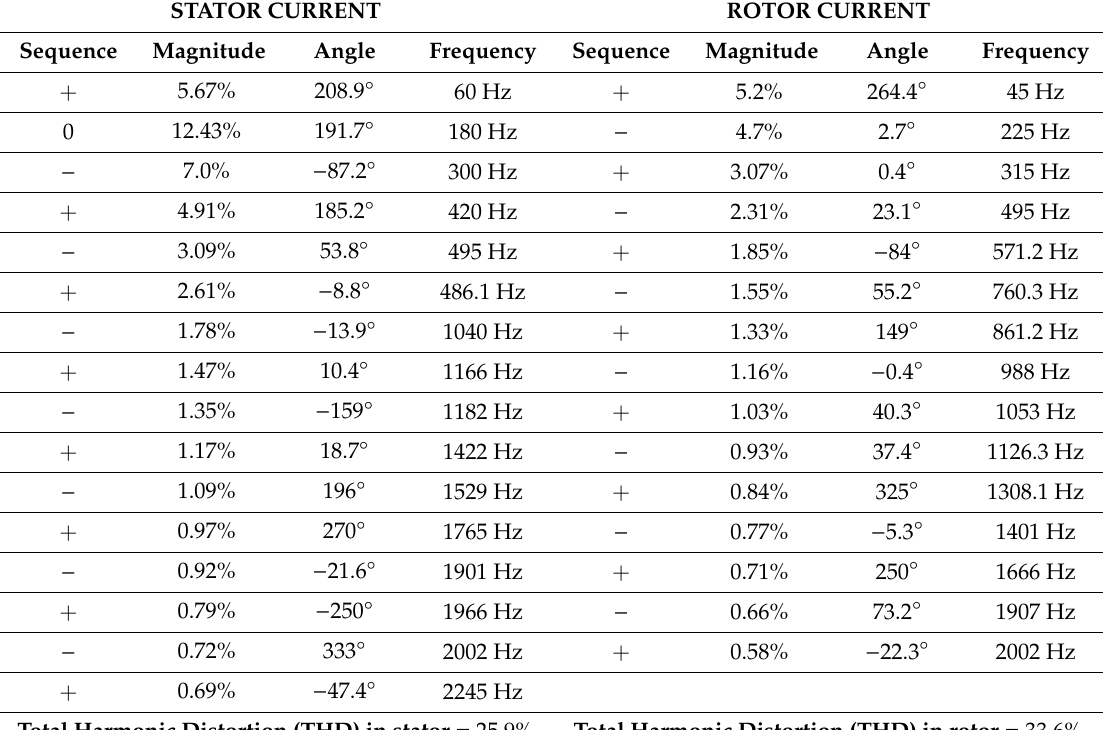
Table 5. Summary of harmonic currents for test case